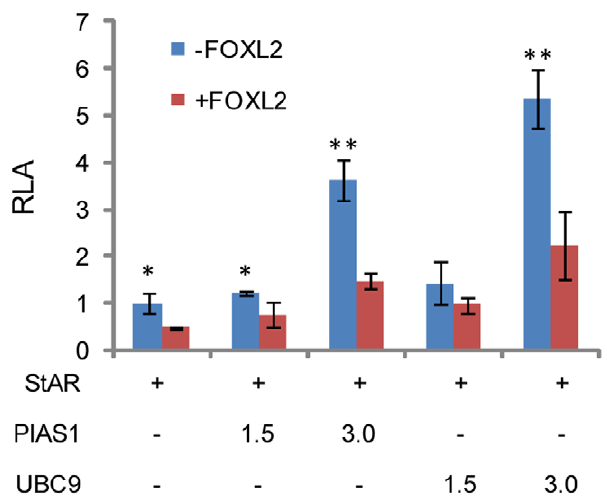
Figure 6. PIAS1 and UBC9 in contrast to FOXL2, activate StAR promoter. COS-7 cells were co-transfected with pGL3-StAR luciferase reporter vector, and increasing amounts (1.5, 3 m g) of PIAS1 or UBC9, with or without FOXL2 (1 m g). Relative luciferase activity is compared